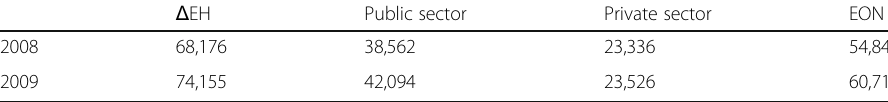
Table 15 How TFP is affected by WPR — Greece Variable Coefficient t statistic Probability Constant 1.325345